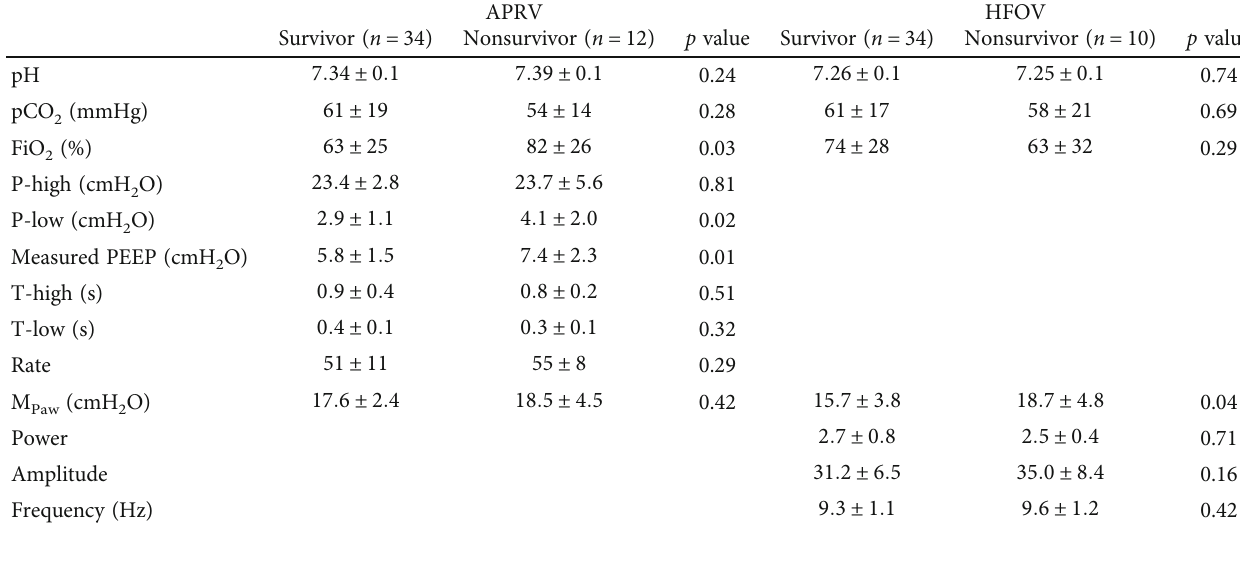
Table 4: Comparison of survivors versus nonsurvivors in each ventilator group.